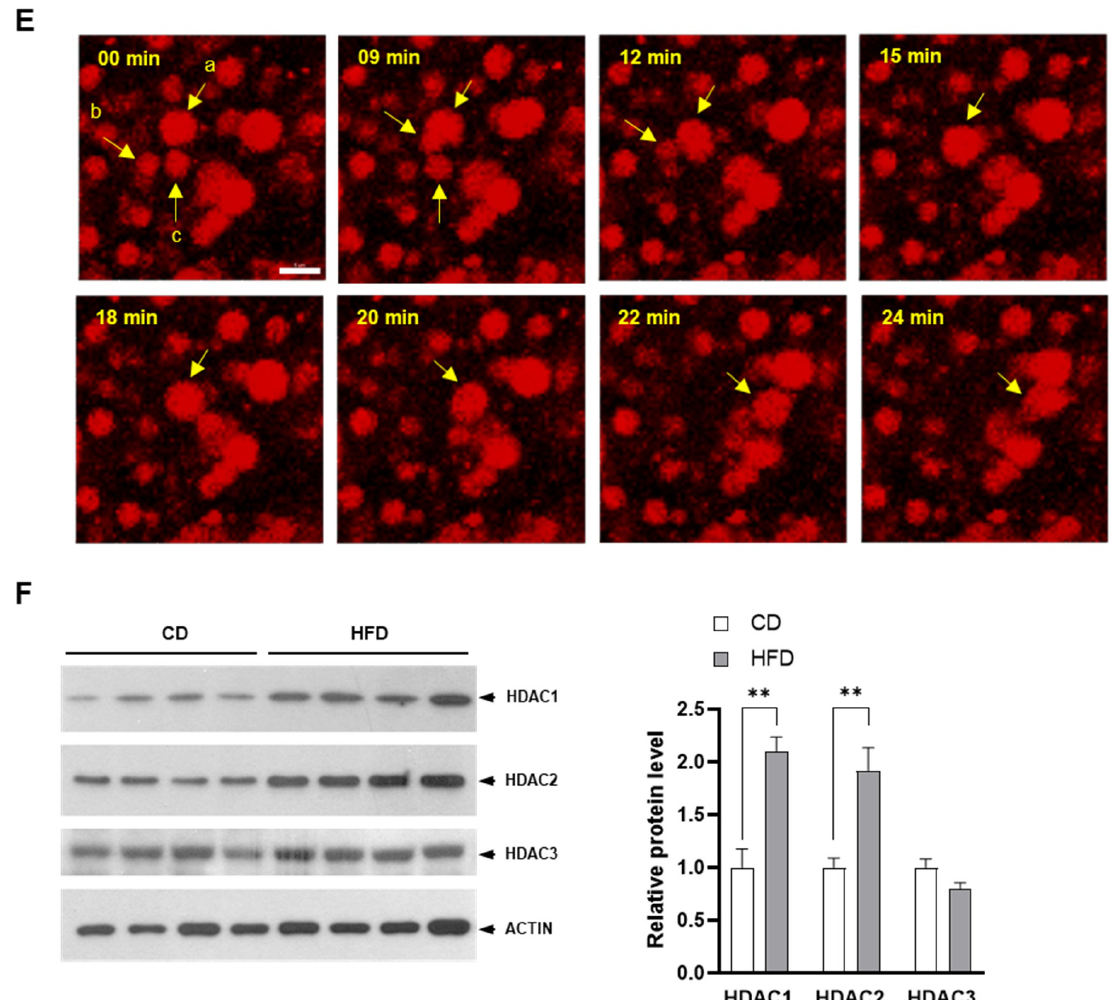
Figure 1. Intravital two-photon imaging of hepatic lipid droplet (LD) accumulation in a high-fat diet (HFD)-induced fatty liver mouse model. C57BL/6J mice were fed a chow diet (CD) or HFD for 14 weeks. Hepatic LDs in mice were stained by intravenous injection with LD1 fluorescent dye (red) and detected by intravital two-photon microscopy. ( A ) Scheme of liver intravital imaging procedure; ( B ) The 3D rendering of intravital two-photon microscopy images of LD accumulation. The nucleus was stained with Hoechst (blue) dye. Scale bar = 50 µm ( C ) LD accumulation was quantified based on LD volume of total image spot. *** p < 0.001 (one-way ANOVA); ( D ) LD volumes were classified as <1000, 1000–10,000, or >10,000 µm 3 ; ( E ) Snapshot images showing the fusion of LDs (yellow arrows) taken from timelapse Video S1 (Supplementary Materials); Scale bar = 5 µm. ( F ) Immunoblots of Class 1 HDAC protein levels (HDAC1–3) in liver tissues of C57BL/6J mice fed a HFD for 14 weeks. ** p < 0.01 (unpaired t -test).